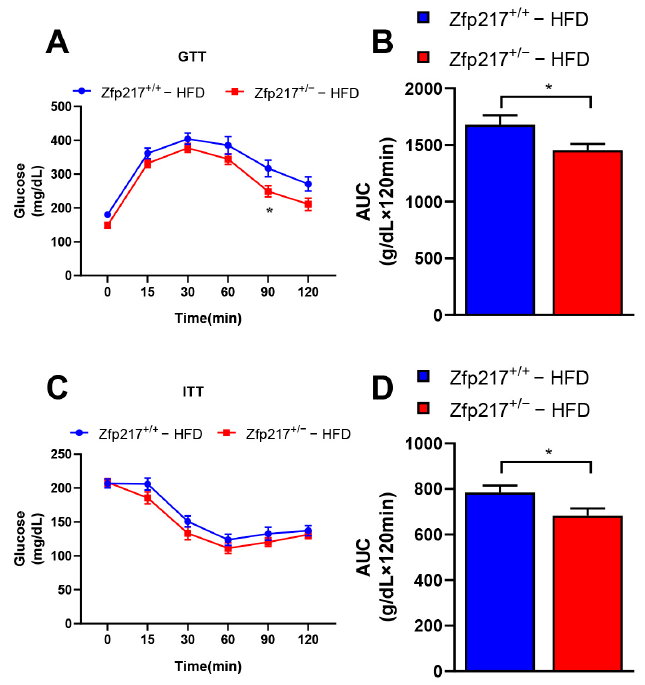
Figure 3. Zfp217 deficiency improves glucose tolerance and insulin sensitivity under HFD. ( A , B ) IP glucose tolerance tests (GTTs) were performed on Zfp217 +/+ and Zfp217 +/ − mice at 14 weeks, and the corresponding areas under the curves were calculated ( n = 8 per group). Comparison at each time point was made against Zfp217 +/+ control mice by two-way ANOVA. ( C , D ) IP insulin tolerance test (ITT) was performed on Zfp217 +/+ and Zfp217 +/ − mice at 15 weeks, and the corresponding areas under the curves were calculated ( n = 8 per group). Comparison at each time point was made against Zfp217 +/+ control mice by two-way ANOVA. For all statistical plots, data are presented as the mean ± SEM. * p < 0.05.